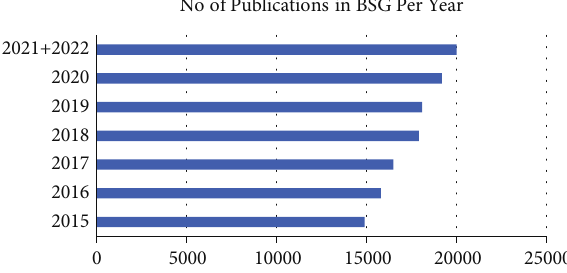
Figure 1: No. of publications in BSG literature from Jan 2015 to Feb